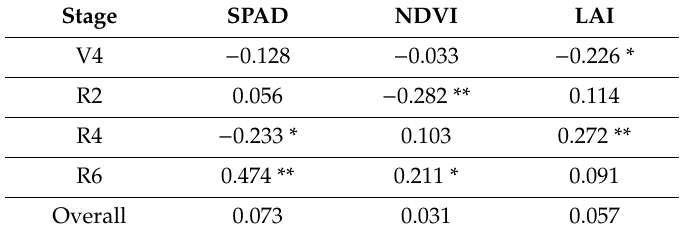
Table 4. Correlation coe ffi cient of SPAD, NDVI, and LAI traits at di ff erent stages with irrigation treatments. Stage